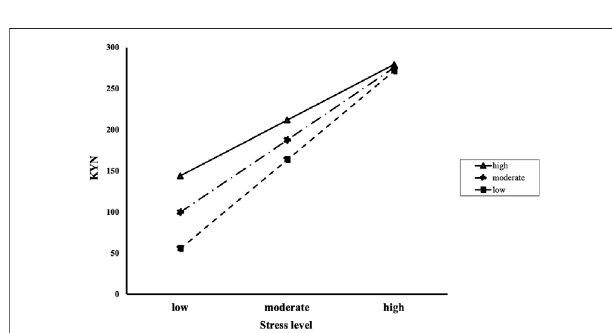
FIGURE 5 | The interaction effects of stress level and resilience on KYN in the alcohol use disorder and healthy control groups. Participants with high resilience showed higher KYN with low(mean — 1 S.D),moderate (mean), and high (mean +1 S.D) stress levels than those with moderate and low resilience. As stress level increased, the differences of KYN decreased according to resilience level. KYN: Kynurenine; S.D: standard deviation; Resilience and stress level were measured using the Connor-Davidson Resilience Scale and Psychosocial Well-Being Index, respectively.